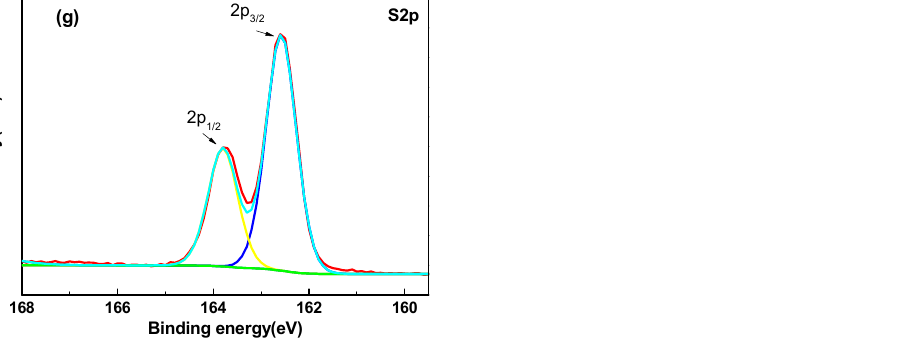
Figure 4. Fracture morphology of S0 ( a ) and EDS results of C ( b ); Si ( c ), and Fracture morphology of S5 ( d ) and EDS results of C ( e ); Si ( f ); Mo ( g ).